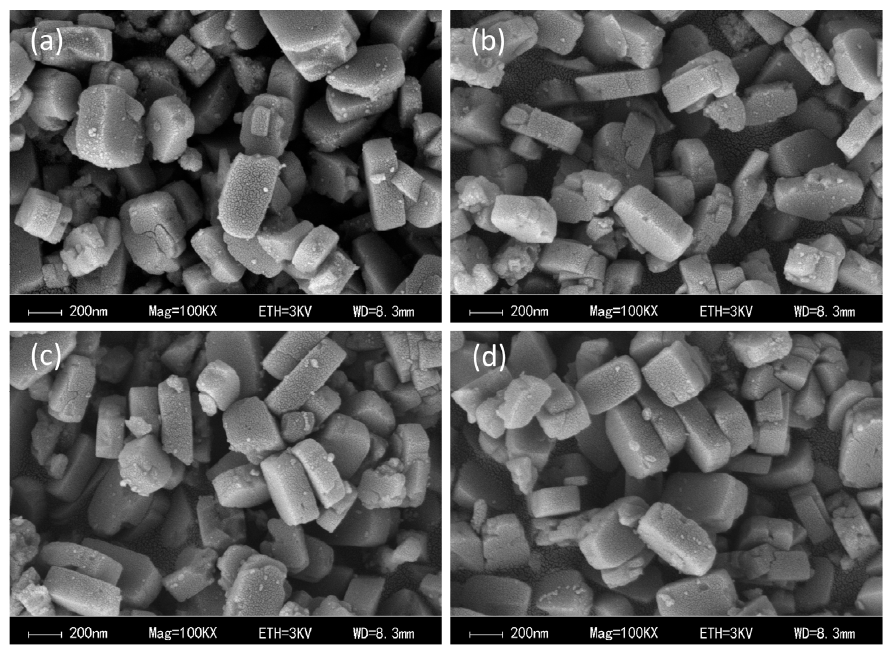
Figure 6. SEM images of samples: ( a ) Mn/ZSM ‐ 5, ( b ) Mn/ZSM5 ‐ S, ( c ) Mn/ZSM ‐ 5 ‐ D, and ( d ) Mn/ZSM ‐ 5 ‐ N. ( d ) Mn/ZSM-5-N.